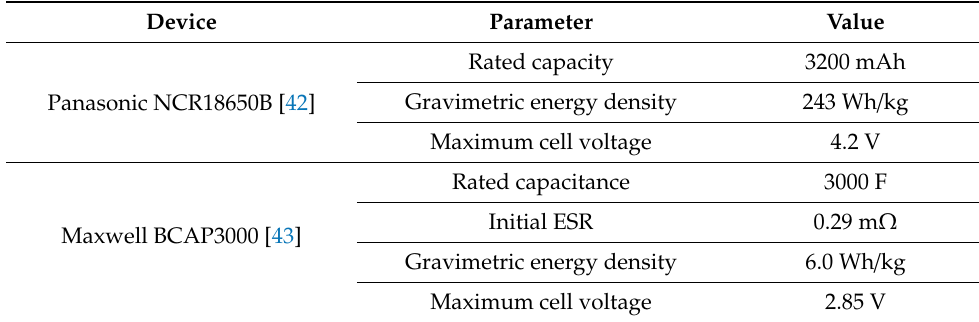
Table 3. ESS device electrical